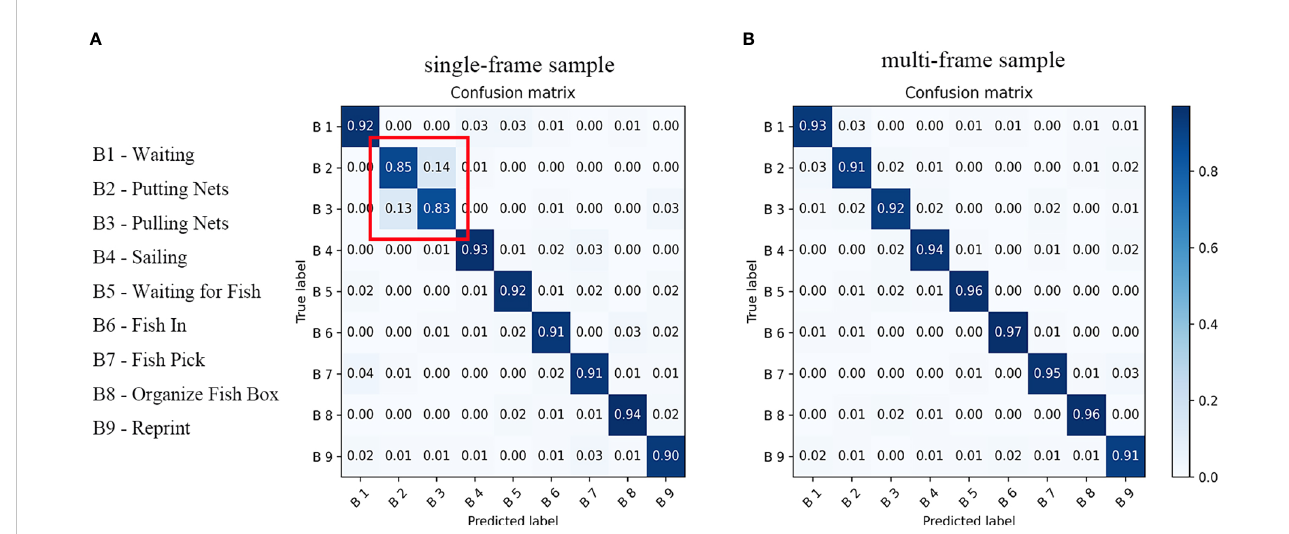
FIGURE 11 Confusion matrix for two different datasets in test set. Part A is the confusion matrix of a single-frame dataset, and part B is the confusion matrix of a multi-frame